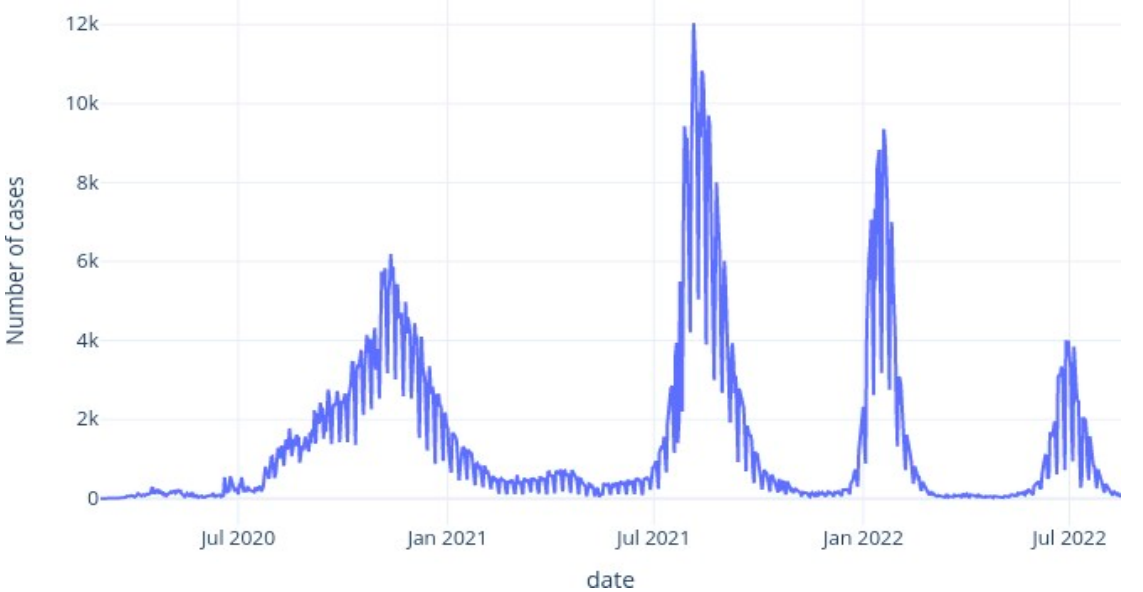
Figure 7. Morocco: evolution of cases per day.